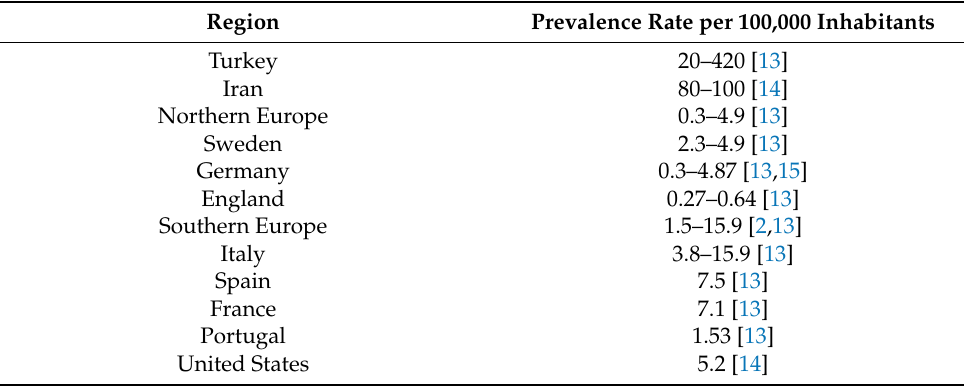
Table 1. Epidemiology of Behçet’s